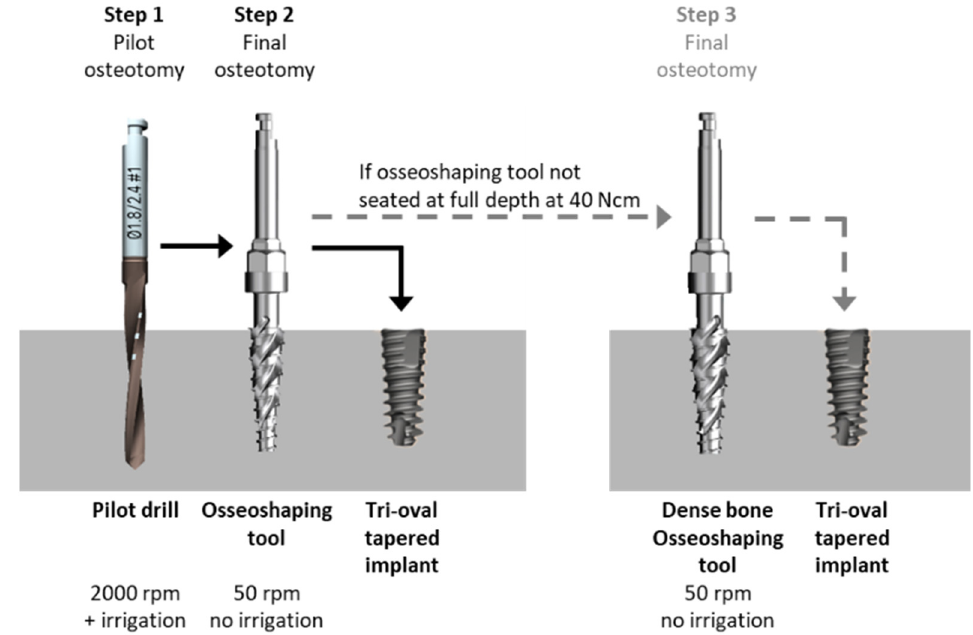
Figure 1. Novel osteotomy formation protocol with the osseoshaping tool.